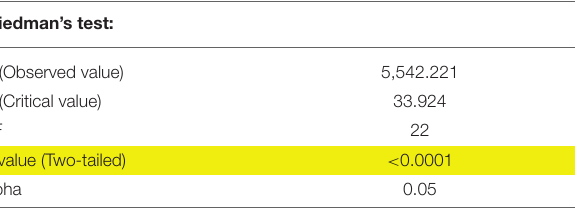
TABLE 2 | Results of the Friedman’s test